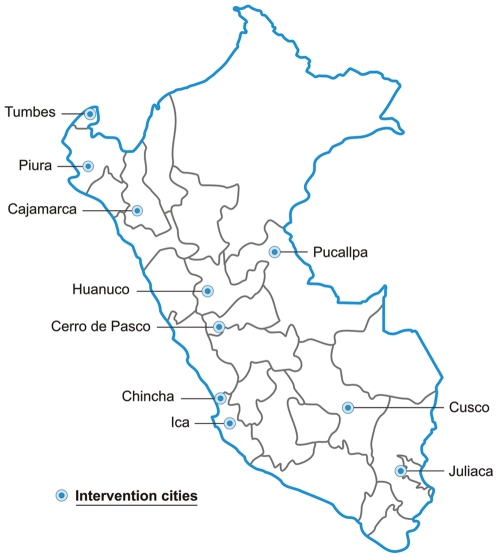
Map of Peru with the location of the 10 intervention cities (each city has more than 50,000 inhabitants).